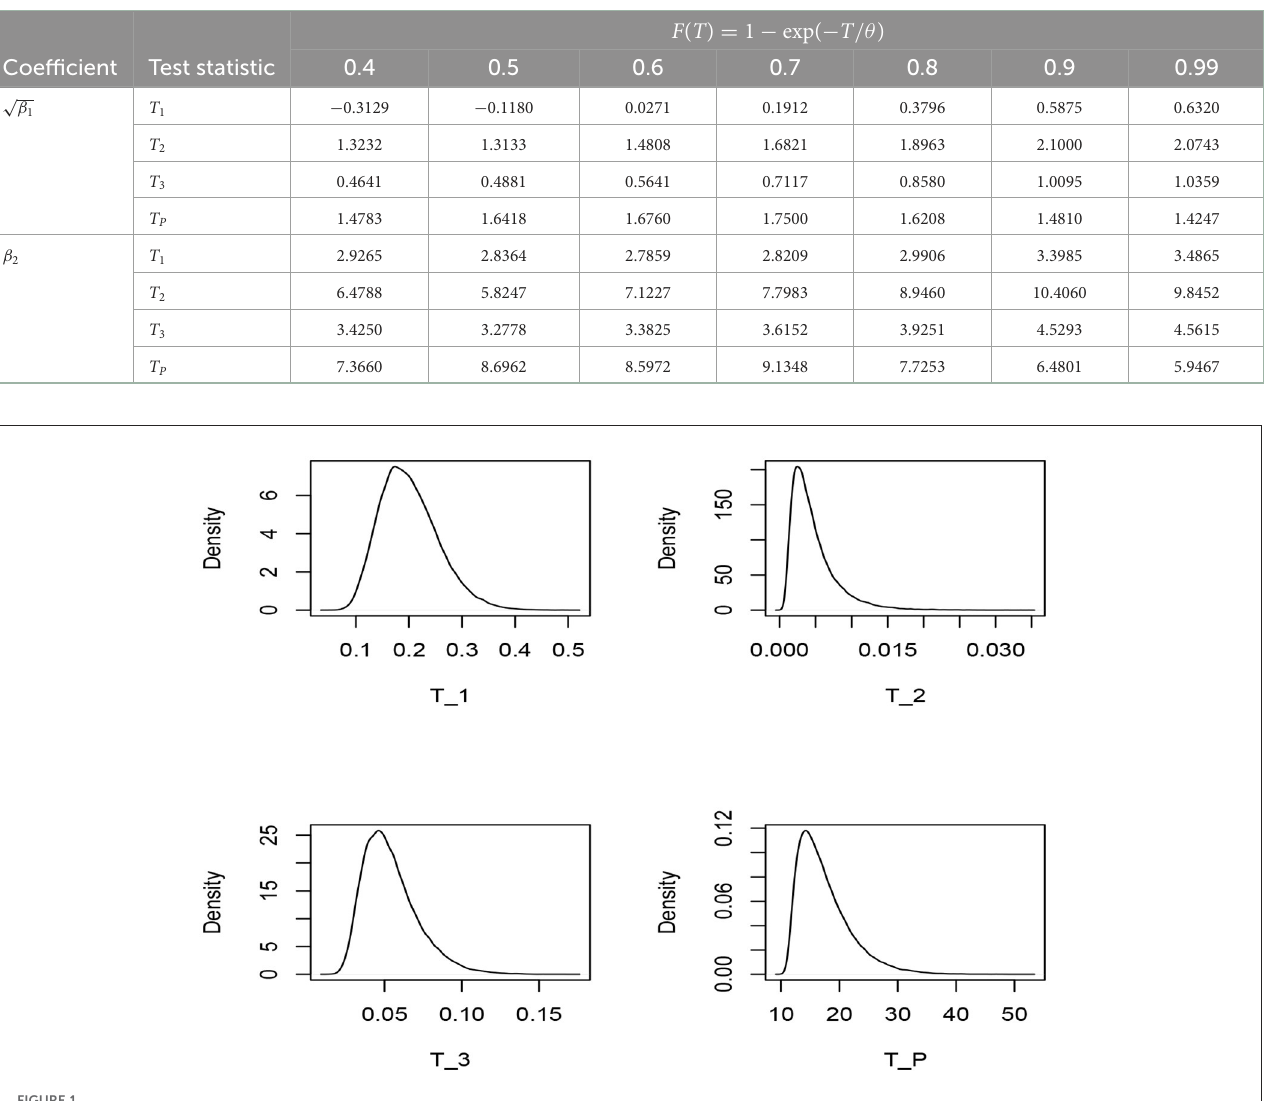
TABLE 1 Monte Carlo estimate of the coefficient of skewness ( √ β 1 ) and coefficient of kurtosis ( β 2 ) for the test statistics T 1 , T 2 , T 3 , and T B under the null distribution of exponentiality.